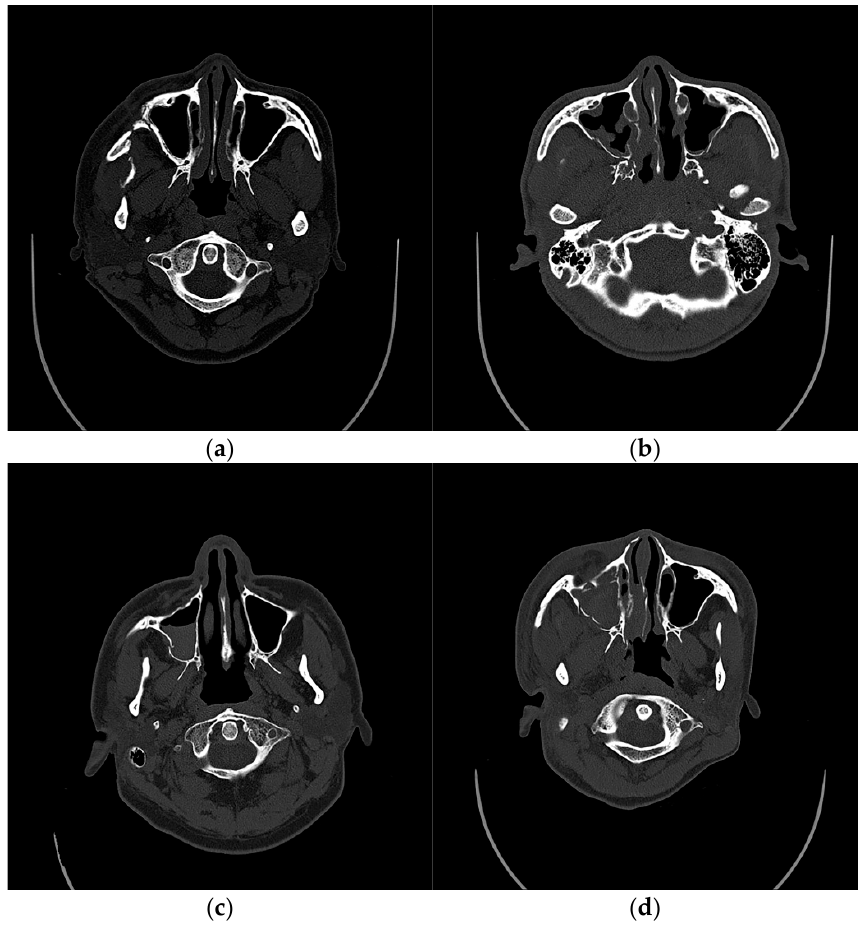
Figure 1. Representative CT sections showing the different preoperative evaluations of the maxillary sinus. ( a ) normal; ( b ) maxillary mucosal thickening; ( c ) gas–fluid level; ( d ) total opacification. Considering the medial and posterior walls of the maxillary sinus were unapproach- able and inaccessible during ORIF, the screws implanted in the anterior wall, superior wall, and floor were counted as the number of screws implanted in the maxillary sinus wall. And once these screws penetrated through the bone wall of the maxillary sinus, they were counted as the number of screws penetrating the maxillary sinus (Figure 2).